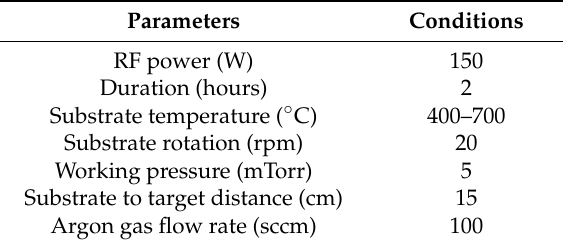
Table 1. Experimental parameters of sputter deposition conditions of YF 3 film.